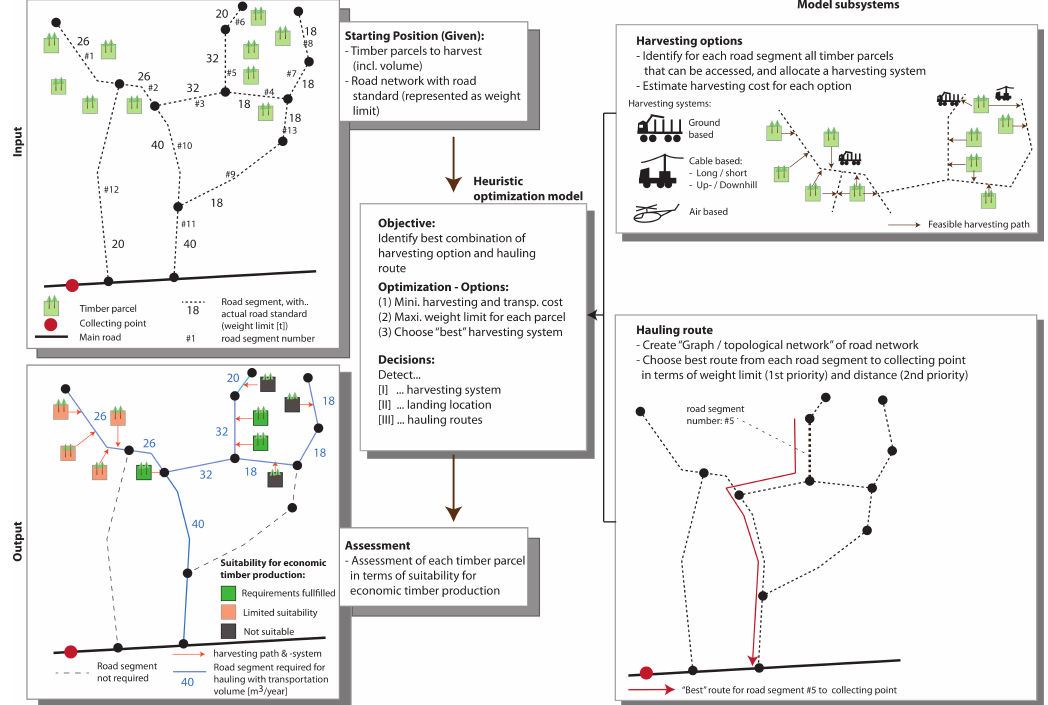
Figure 1. Conceptual model with input and output values ( left ) and subsystems ( right